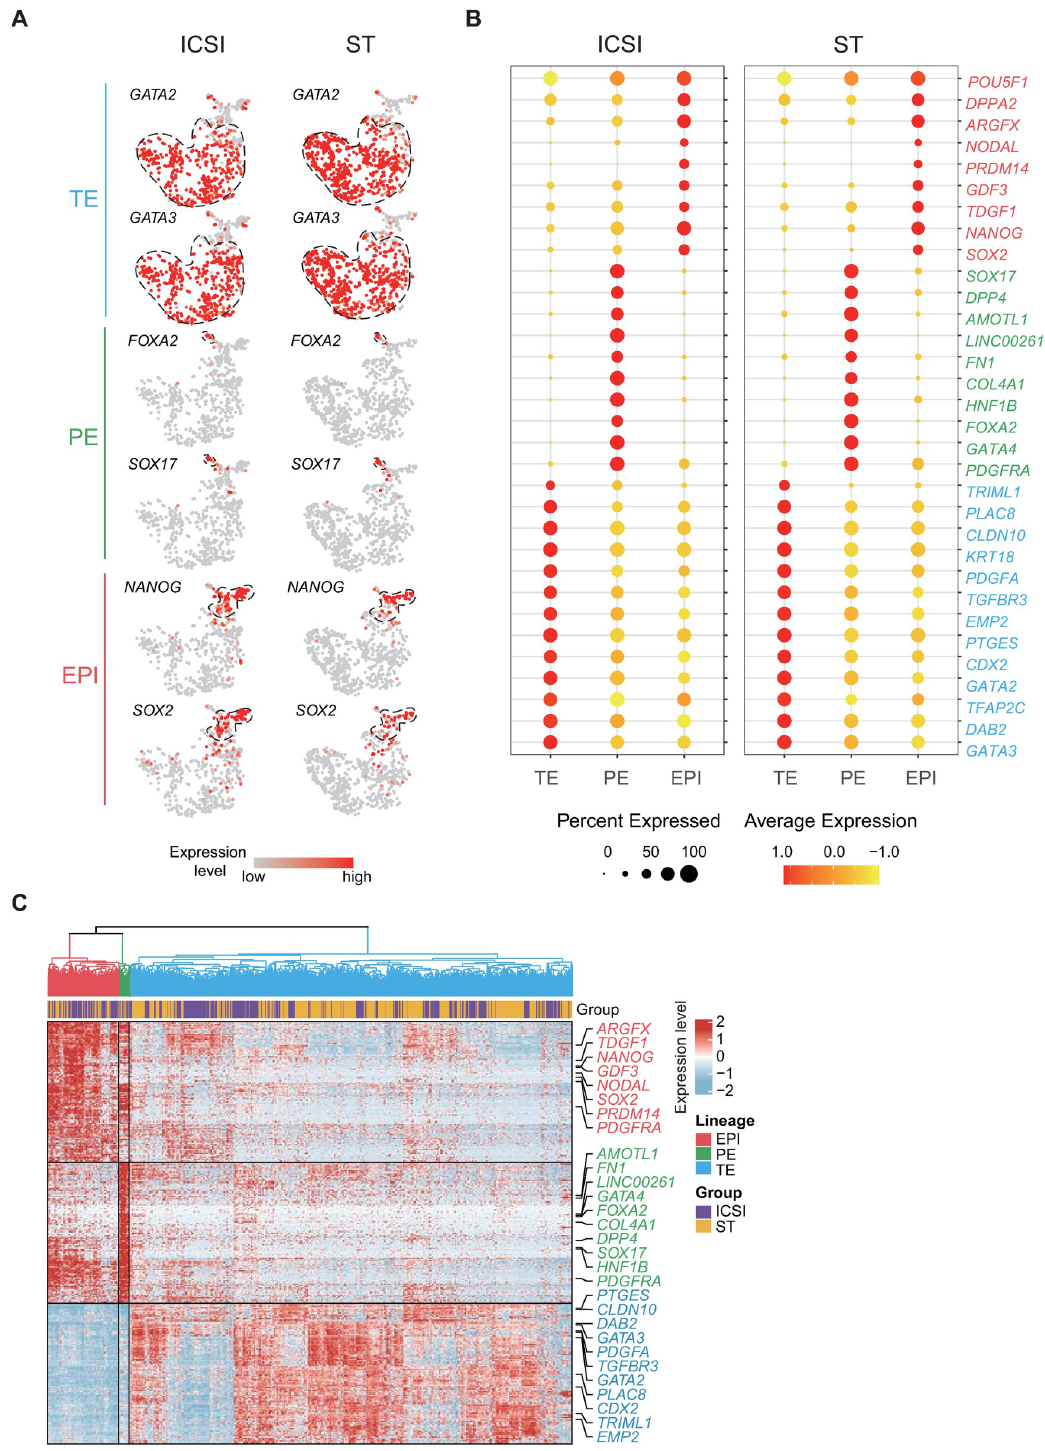
Fig 2. Lineage identification of scRNA-seq data. (A, B) The lineage identification results were verified by (A) the expression levels of high-confidence lineage markers and (B) the expression levels and percentages of lineage marker sets. (C) Expression patterns of lineage signature genes. Hierarchical clustering of 1,397 cells with Euclidean distance according to the Ward.D2 method. And lineage-specific genes were identified and intersected with known markers of the corresponding lineages. The numerical data are listed in S1 Data. EPI, epiblast; ICSI, intracytoplasmic sperm injection; PE, primitive endoderm; ST, spindle transfer; TE, trophectoderm. https://doi.org/10.1371/journal.pbio.3001741.g002 PLOS Biology | https://doi.org/10.1371/journal.pbio.3001741 August 16,